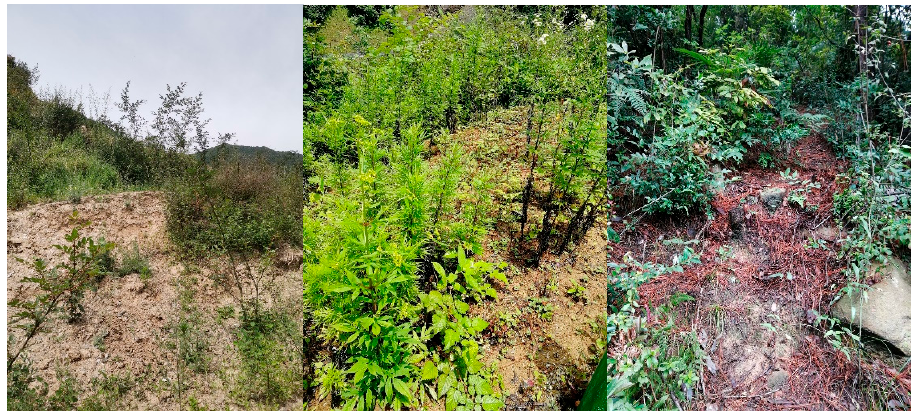
Figure 6. Field research photos of the Qinling–Daba Mountains nature reserves.